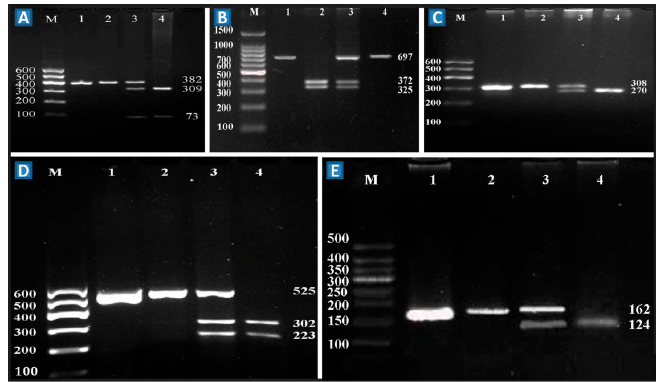
Figure 1. Genotyping of the rs1333040, rs1333042, rs4977574, rs2066715 and rs2740483 SNPs on the